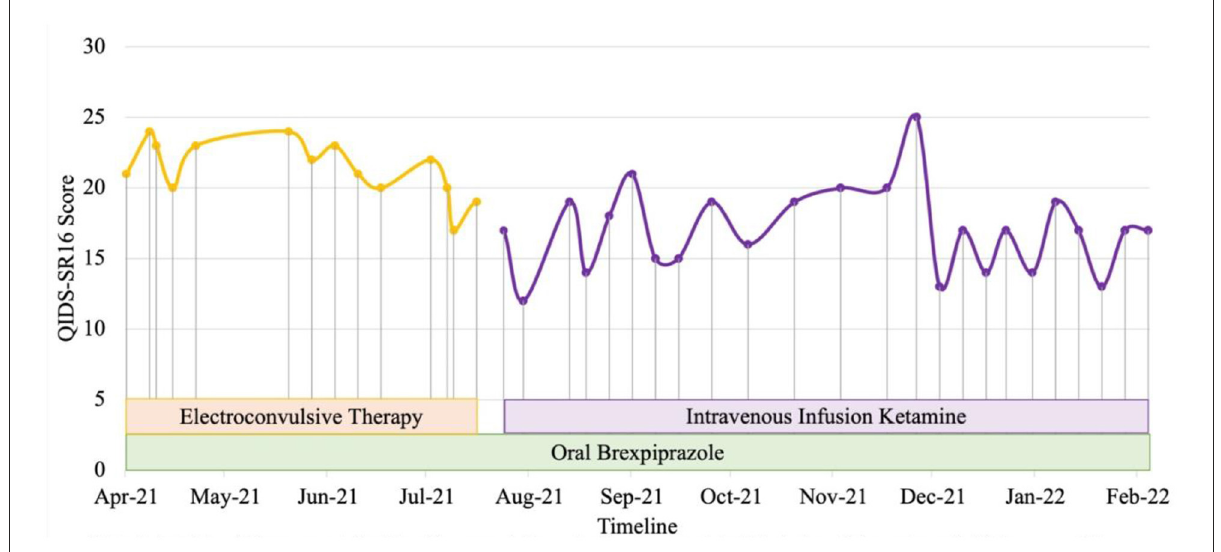
FIGURE1 Case 1 timeline for longitudinal course of treatment response. Patient 1 is a Malay woman in her 20s with a current diagnosis of treatment-resistant bipolar type II depression with lifetime co-morbid diagnoses of complex post-traumatic stress disorder, obsessive-compulsive disorder and borderline personality disorder. Brexpiprazole was initiated at the dose of 0.5mg and titrated to a maximum of 4mg. Intravenous infusion ketamine 0.5 mg/kg is initiated at July 2021 to replace ECT due to cognitive impairment as a side effect of ECT. Co-medications include lamotrigine 200mg, sodium valproate 2g, quetiapine 300mg, and clonazepam 2mg PRN. Currently, she has lesser obsessive, PTSD and depressive symptoms, including marked reduction in intensity and frequency of suicidal thoughts with improvement in her functionality.